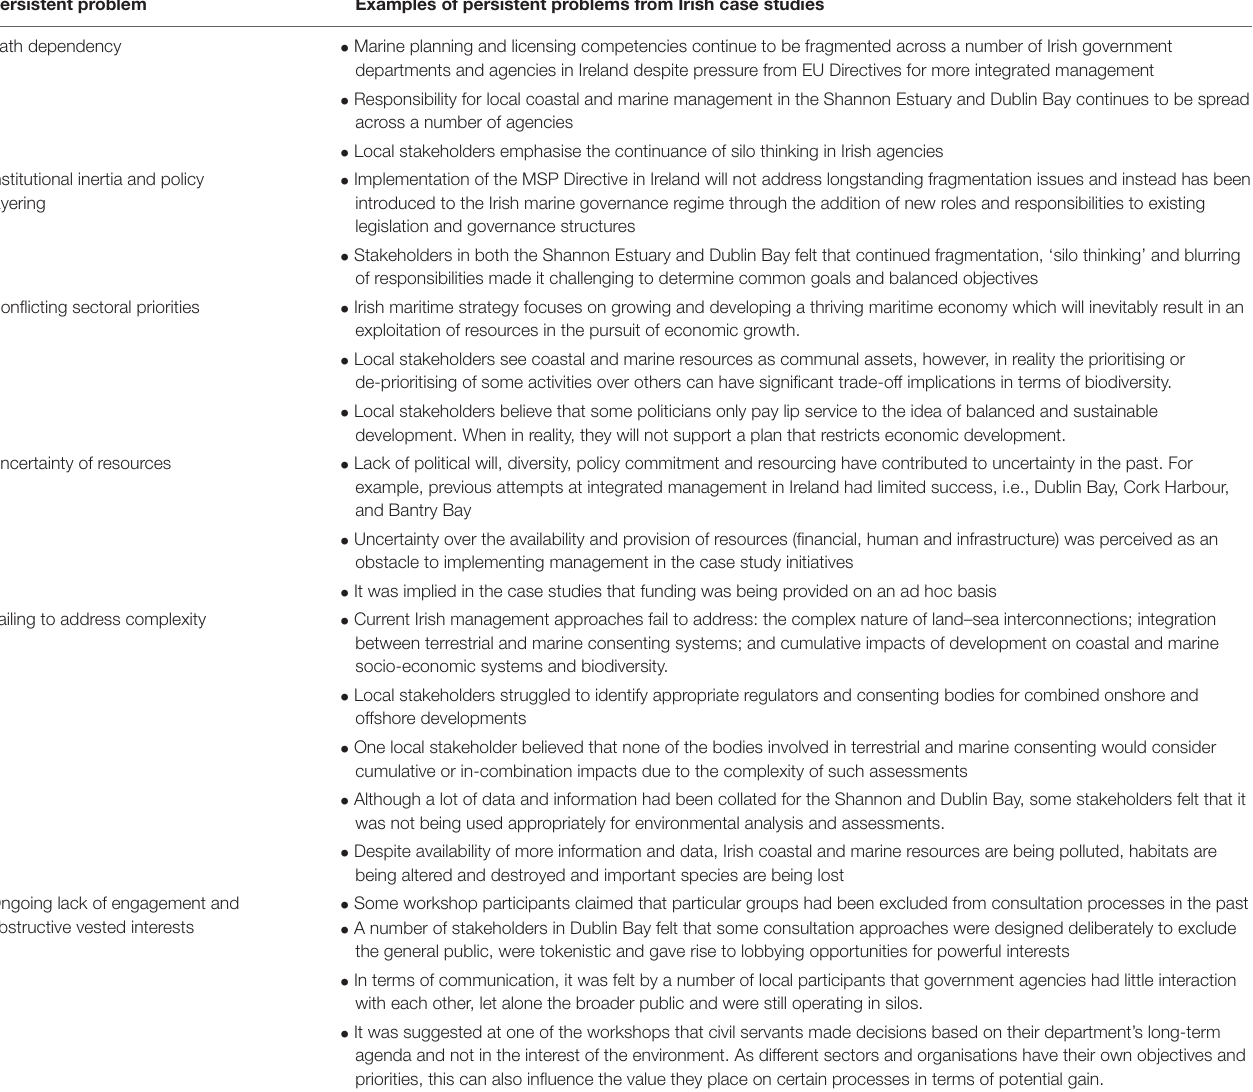
TABLE 3 | Summary of persistent problems and examples from an Irish